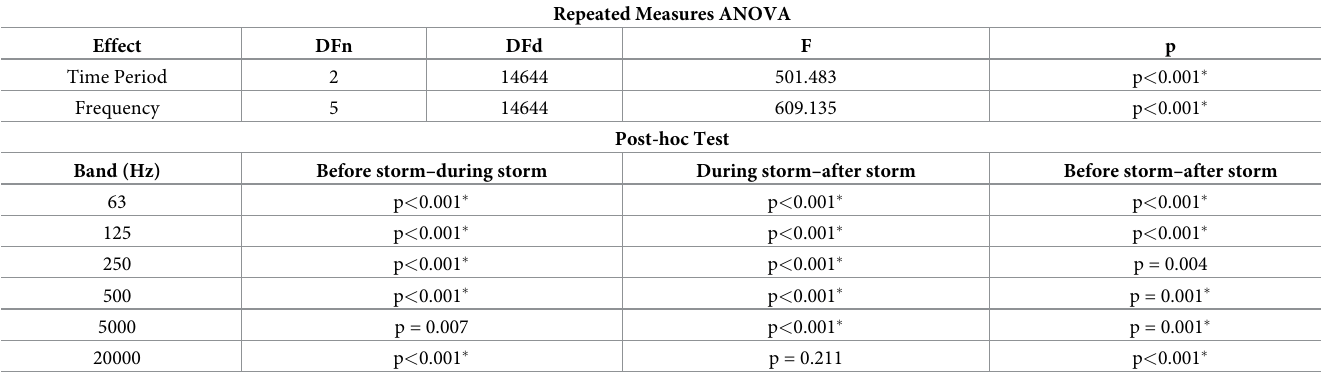
Table 1. Boca 3 repeated measures ANOVA and post-hoc test on sound pressure levels.